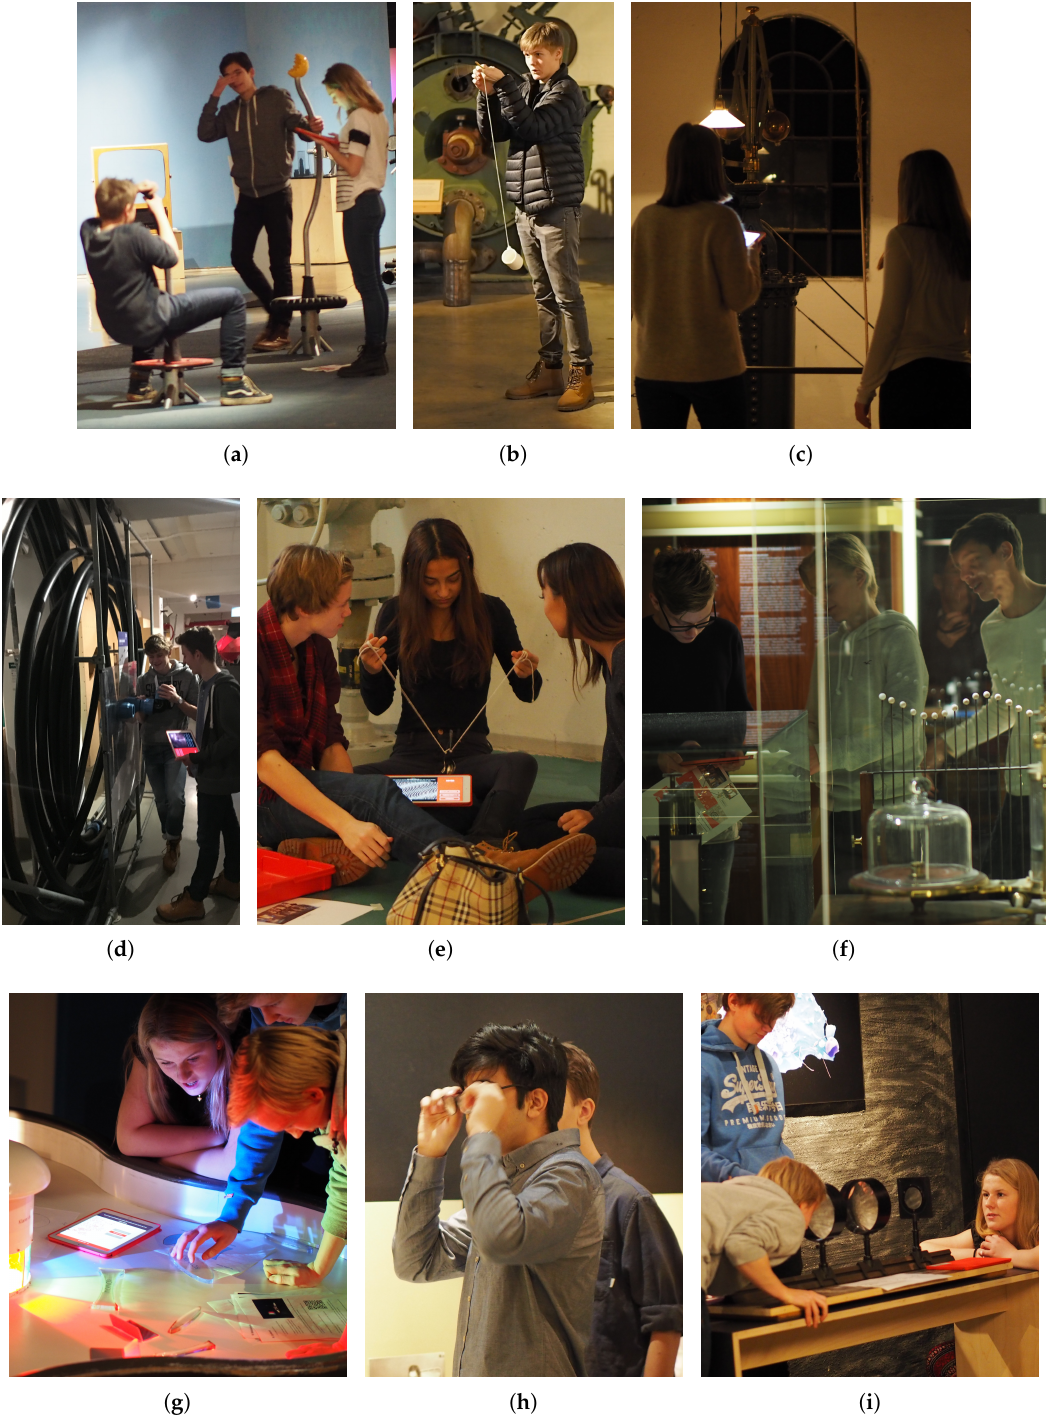
Figure 2. Examples for the experiments in the three learning trails: “Forces” ( a – c ); “Sound” ( d – f ); and “Light” ( g – i